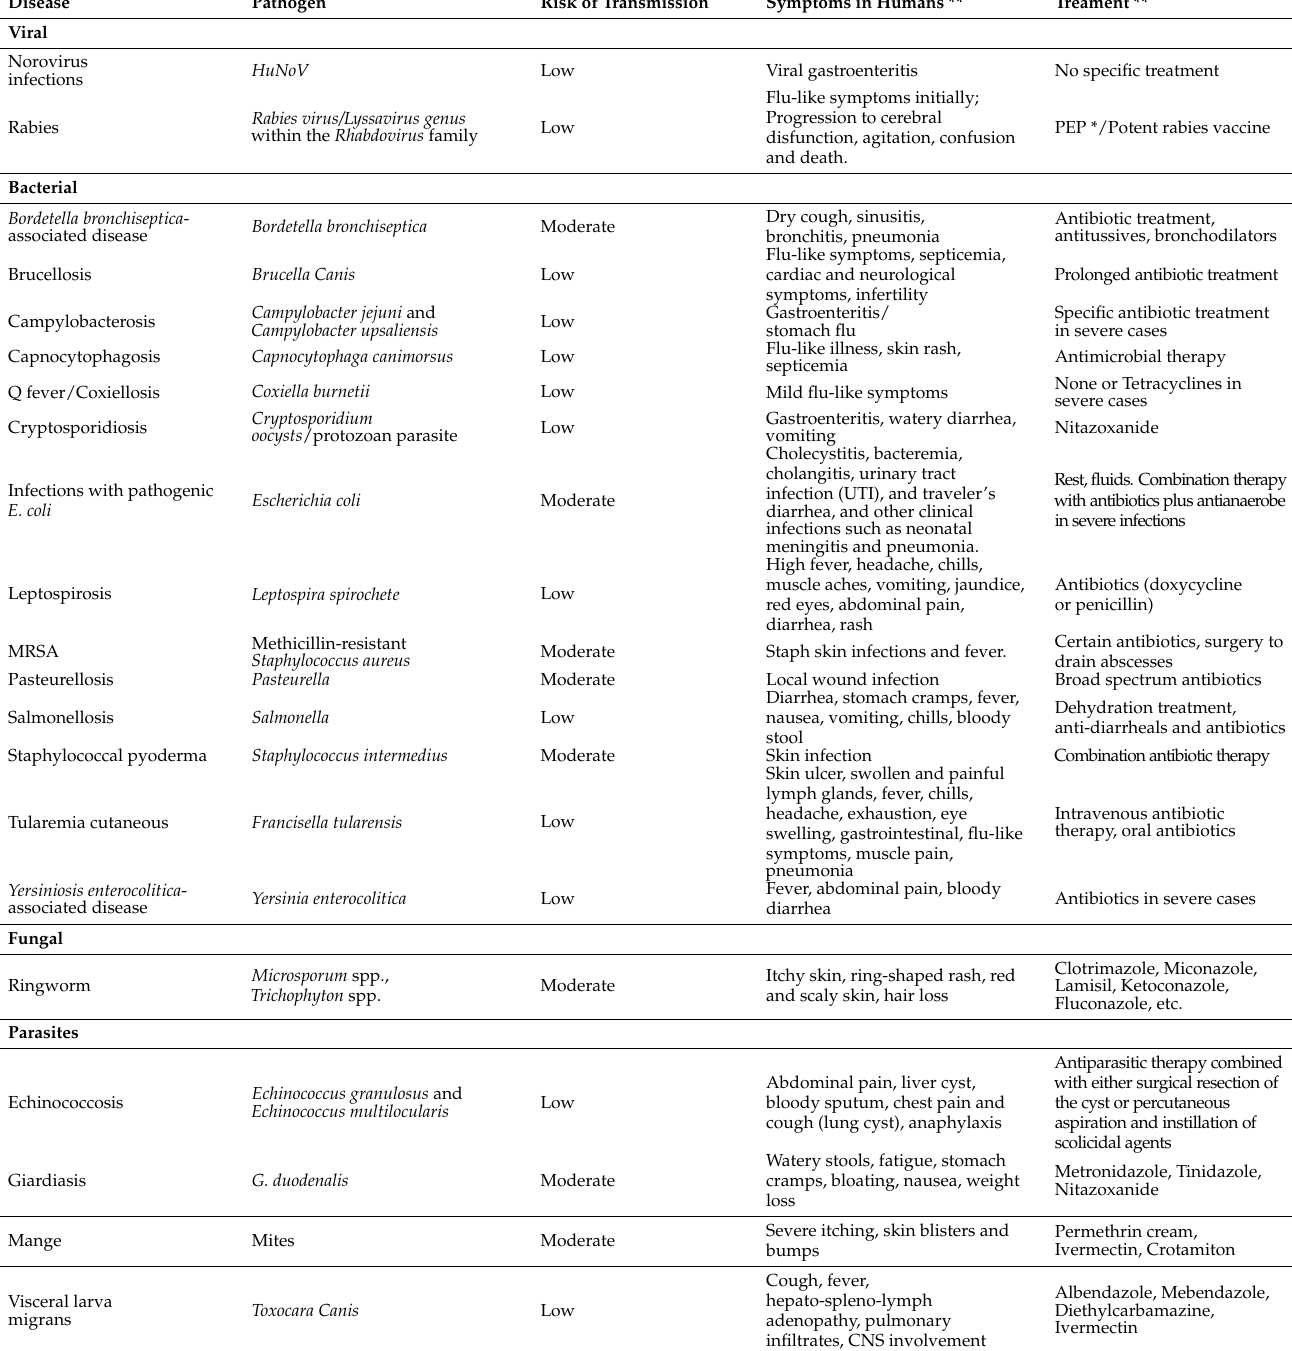
Table 2. Common Zoonoses Associated with